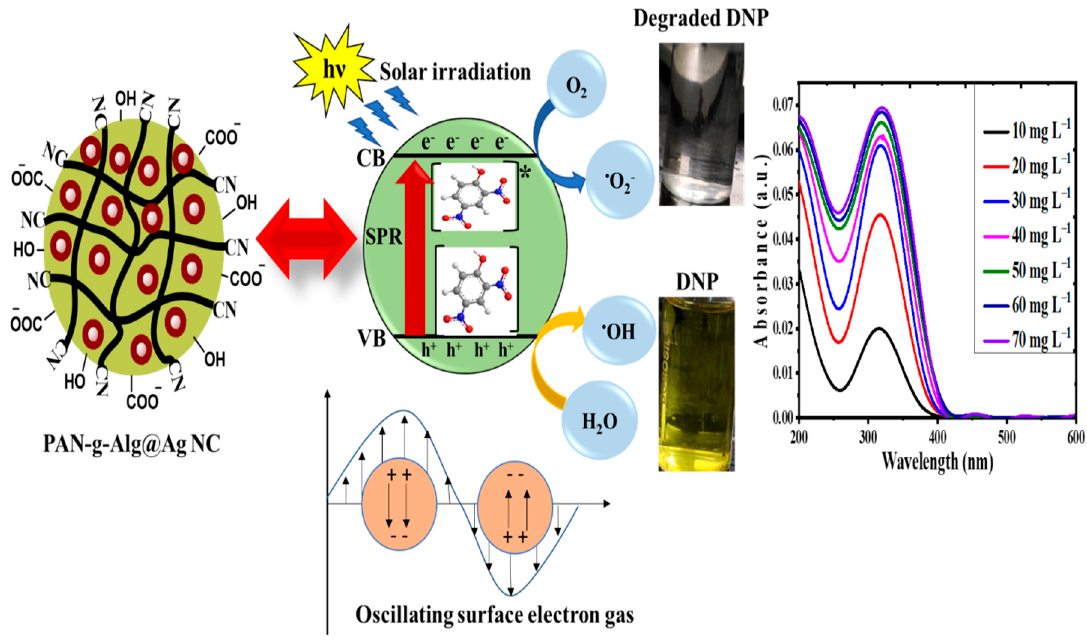
Figure 11. Photodegradation mechanism of DNP by PAN-g-Alg@Ag under direct solar irradiation.